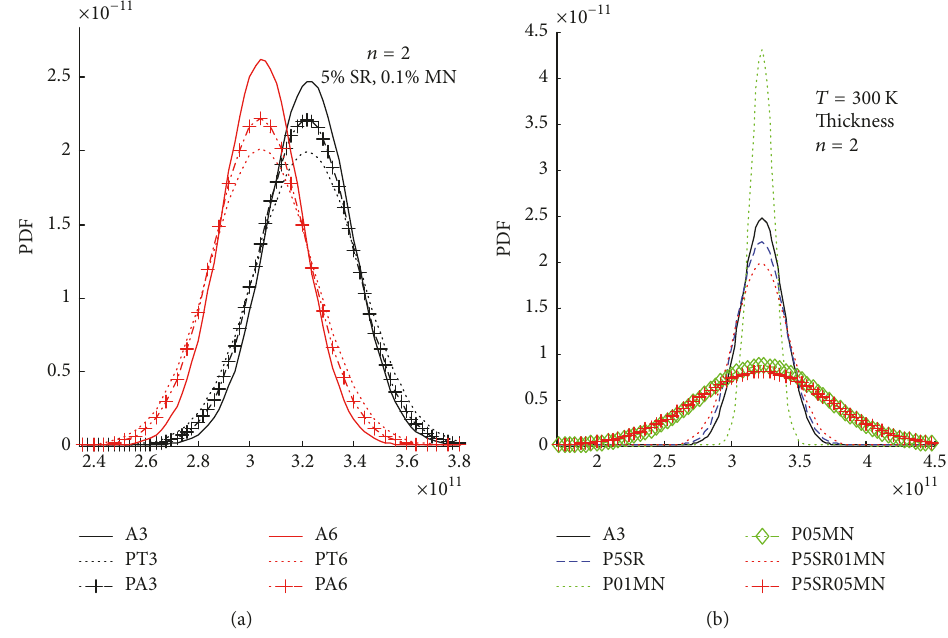
Figure 10: Identified PDFs of ceramics material elastic modulus for different cases.